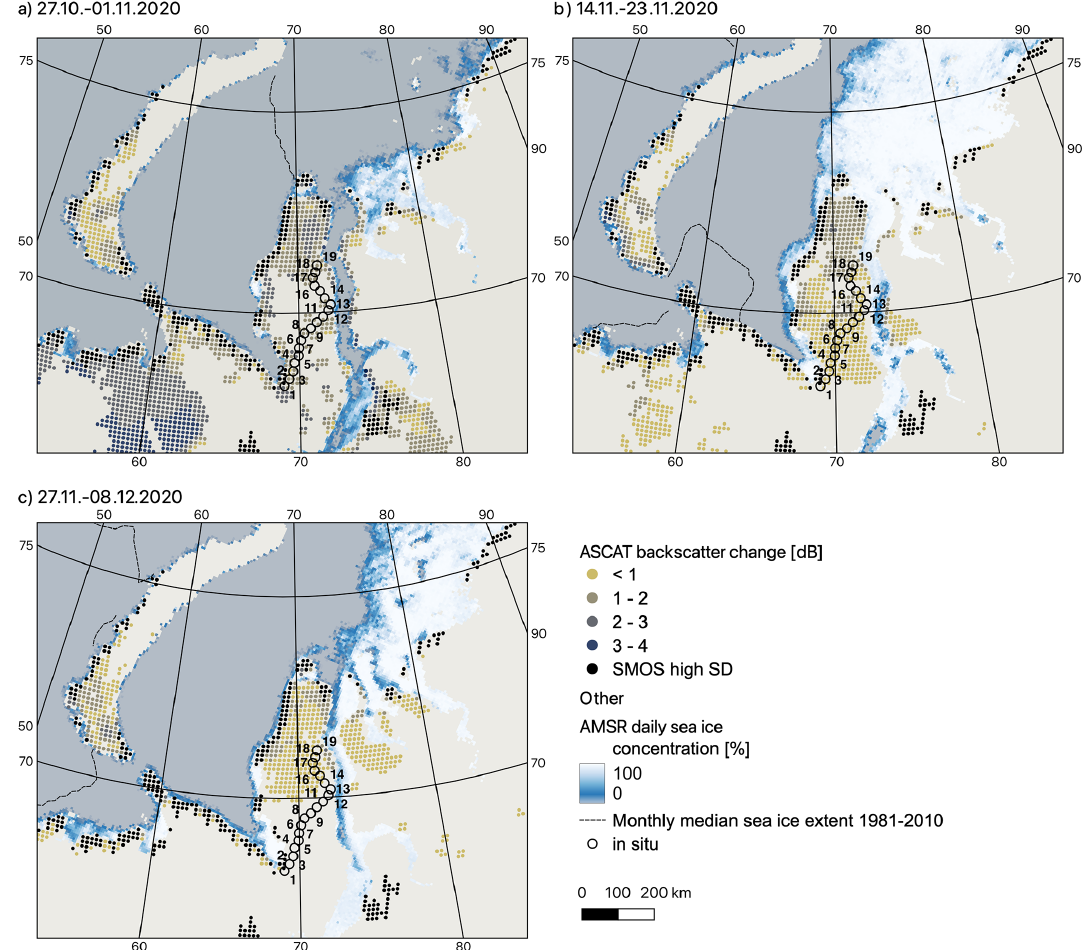
Figure 5. Cumulative ASCAT (cid:49)σ 0 (in dB, including SMOS masking for wet snow and RFI) and AMSR sea ice extent (source: University of Bremen; Spreen et al., 2008) for event series in early winter 2020 on the Yamal Peninsula. (a) 27 October–1 November 2020, sea ice extent